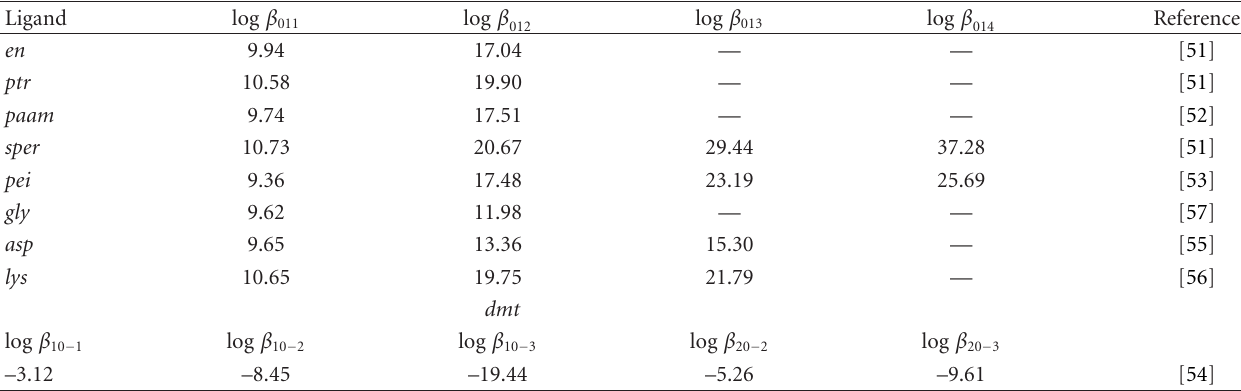
Table 1: Dimethyltin(IV) hydrolysis constants and protonation constants of ligands used, in NaCl aq at I = 0 . 1 mol L − 1 and t = 25 ◦ C. log β pqr refer to equilibrium reported in (1).